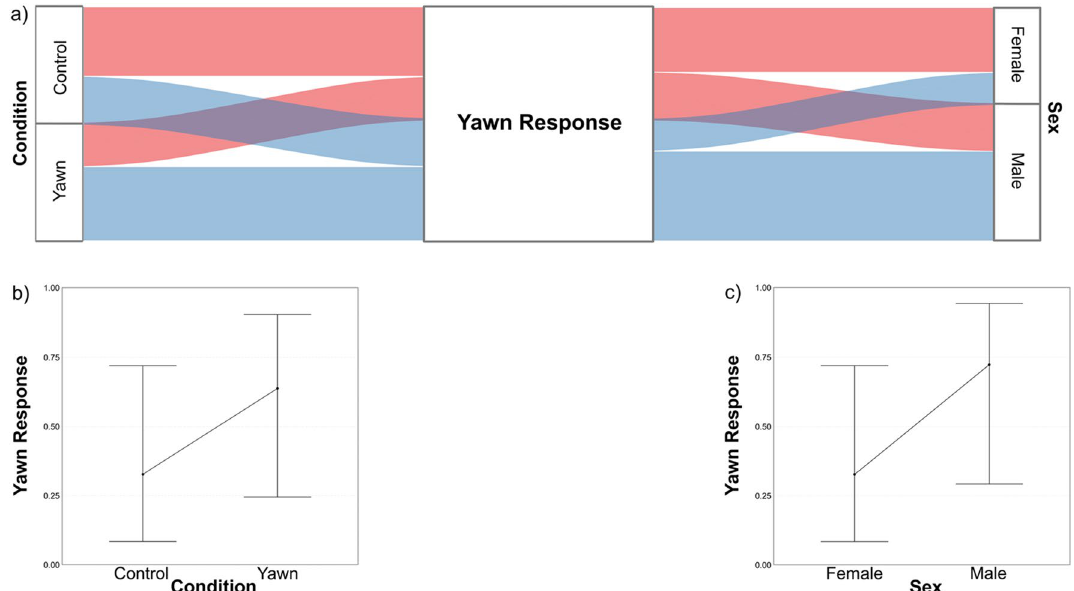
Figure 2. Results of Model 1c (Yawn Response as response variable) showing the effect of the significant predictors. ( a ) Alluvial plot showing the occurrence of Yawn Response (Blue streams = presence; Pink streams = absence) for each level of the factors “Condition” (Yawn vs Control) and “Sex” (Male vs Female). ( b ) Effect of the variable Condition on the Yawn response. ( c ) Effect of the variable Sex on the Yawn Response. Bands represent the confidence